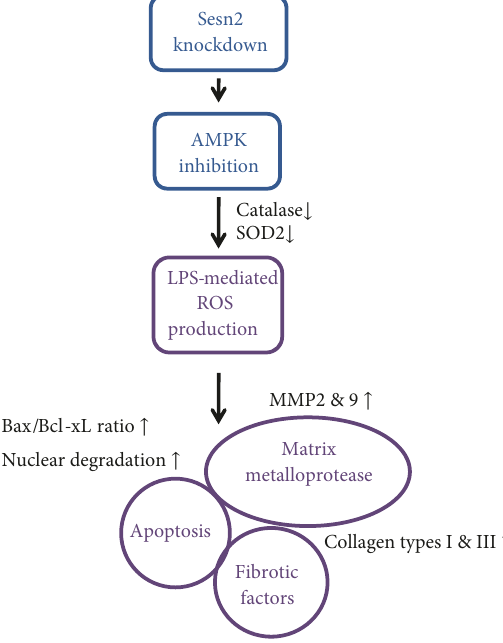
Figure 6: Schematic diagram of sesn2 functions in cardiac tissue. Sesn2 knockdown increases LPS-mediated oxidative stress, apoptosis, and fi brotic reactions in cardiomyocytes by inhibiting AMPK